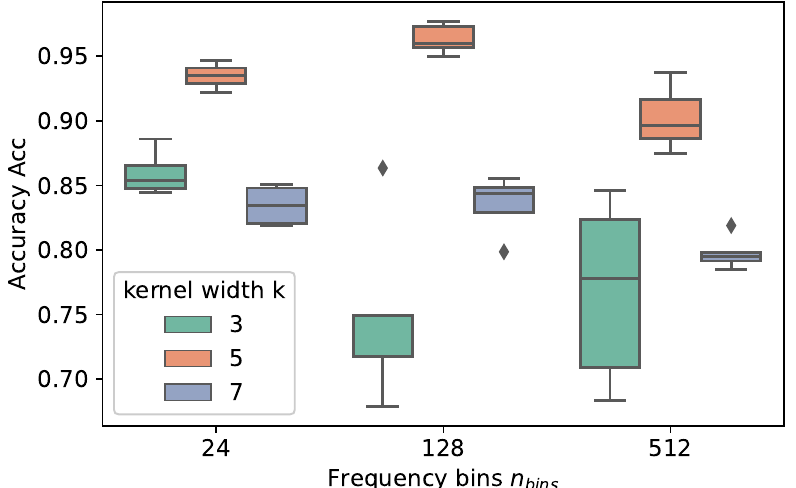
Figure 10. Accuracy with different kernel widths k and frequency bins n bins achieved on the validation data splits of 5-fold cross-validation.